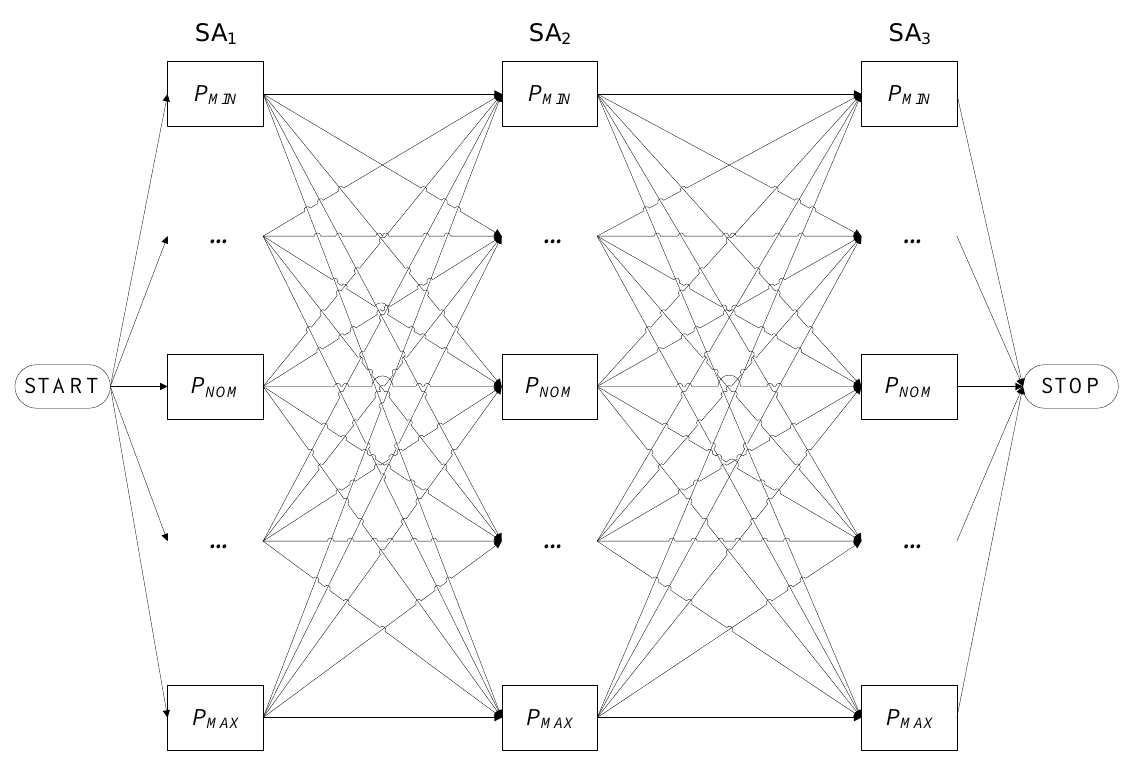
Figure 5. An example of presenting the complexity of the power selection options for three